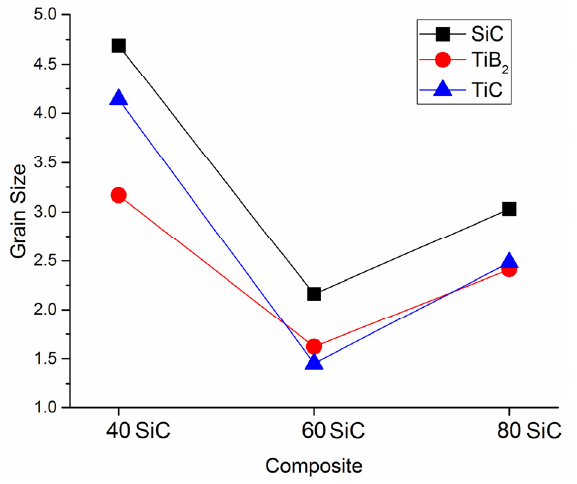
Figure 6. Average grain size ( μ m) of SiC, TiB 2 , and TiC in the 80SiC, 60SiC, and 40SiC composites.